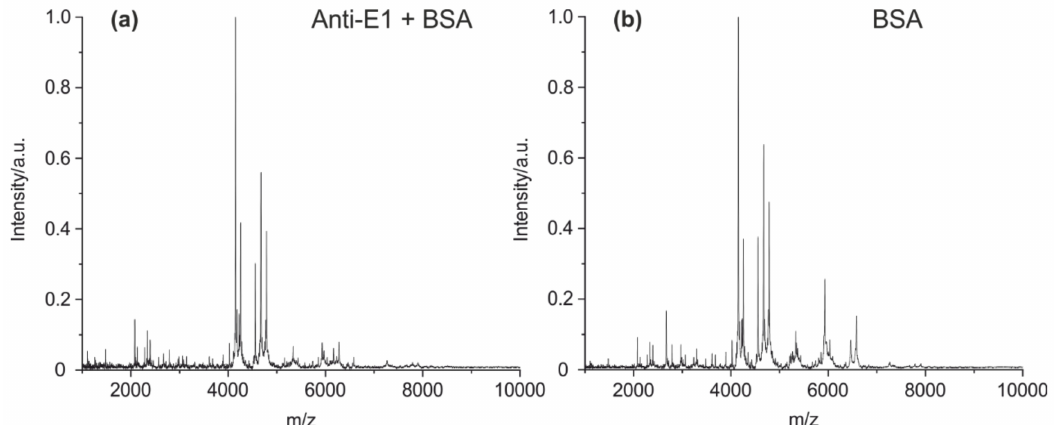
Figure 2. MALDI-TOF MS spectra of ( a ) mouse IgG + BSA (concentration ratio 1:10) and ( b ) cleaved bovine serum albumin (BSA, 100 µ g / mL). The dominance of the BSA peaks may impede the analysis of the antibody fragments. Therefore, the separation of IgG from any additives by magnetic particles coated with protein A or G is recommended, if the purity and / or concentration of the IgG sample is